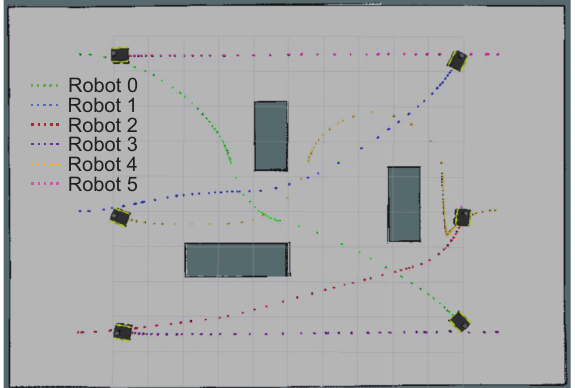
Fig. 14 Planned robot trajectories obtained using the P- MPCC method.